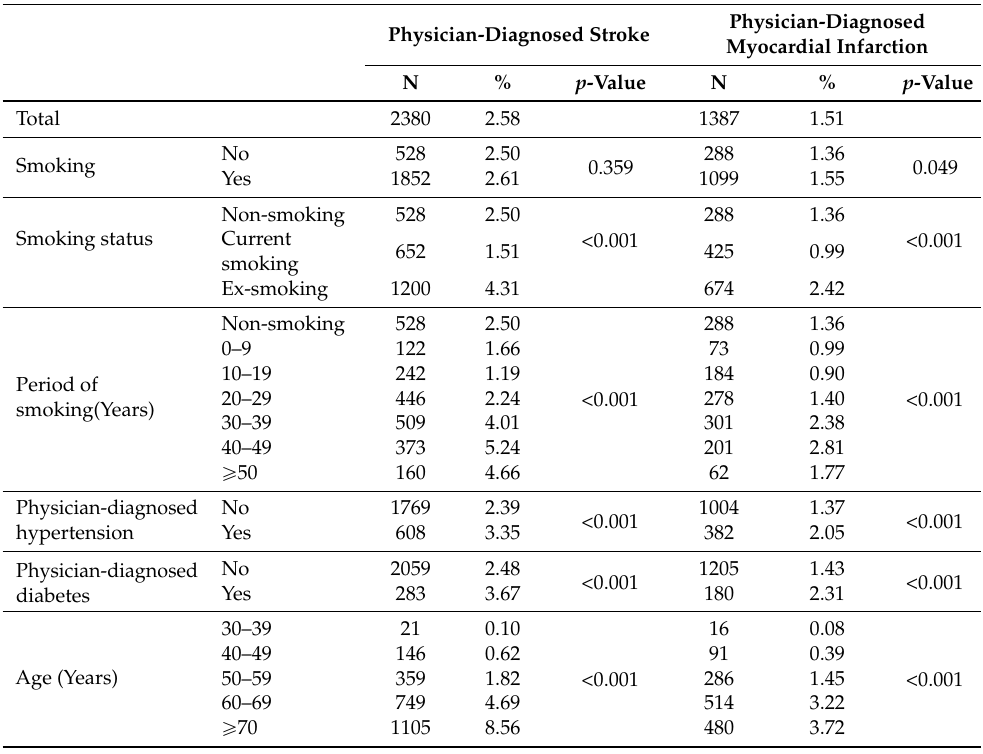
Table 2. Prevalence of physician-diagnosed stroke and myocardial infarction by smoking variables.